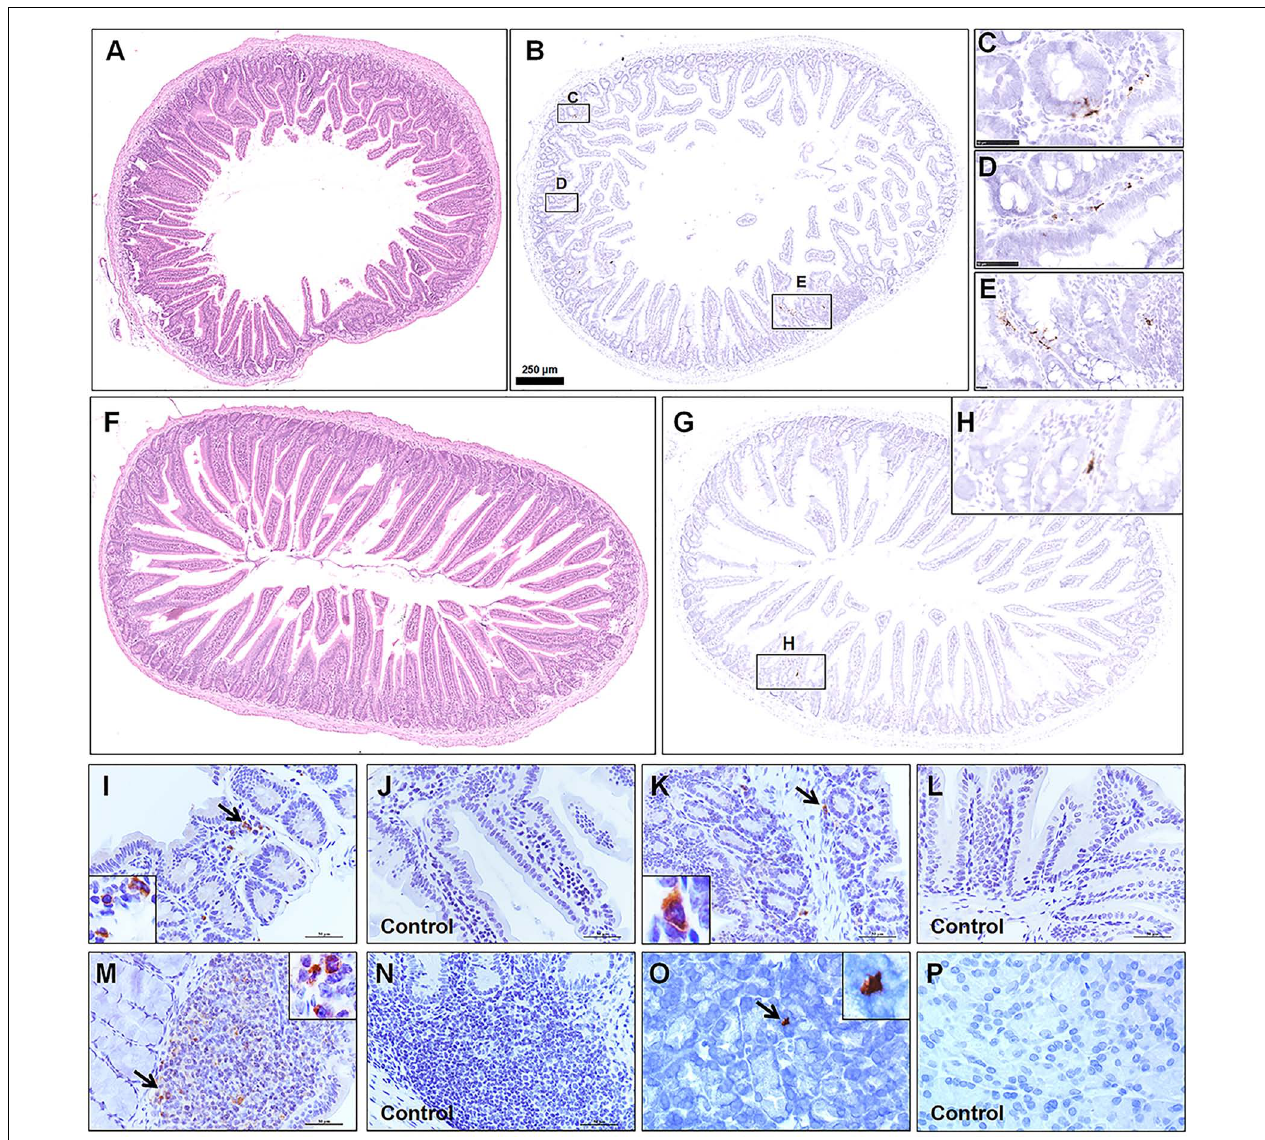
FIGURE 4 | Observation and examination of the alimentary system at 5 dpi. (A–E) Observation of the duodenum by H&E and examination by ISH. (F–H) Observation of the jejunum by H&E and examination by ISH. (I–P) The ileum, colon, Peyer’s lymph nodes, and pancreas tissues from the infected group and mock control group were examined by IHC. The black frames in the corners are a magnification of the arrowed region in the respective panel. Sequential sections were stained by H&E and subjected to ISH and IHC. Data are representative of three independent experiments.